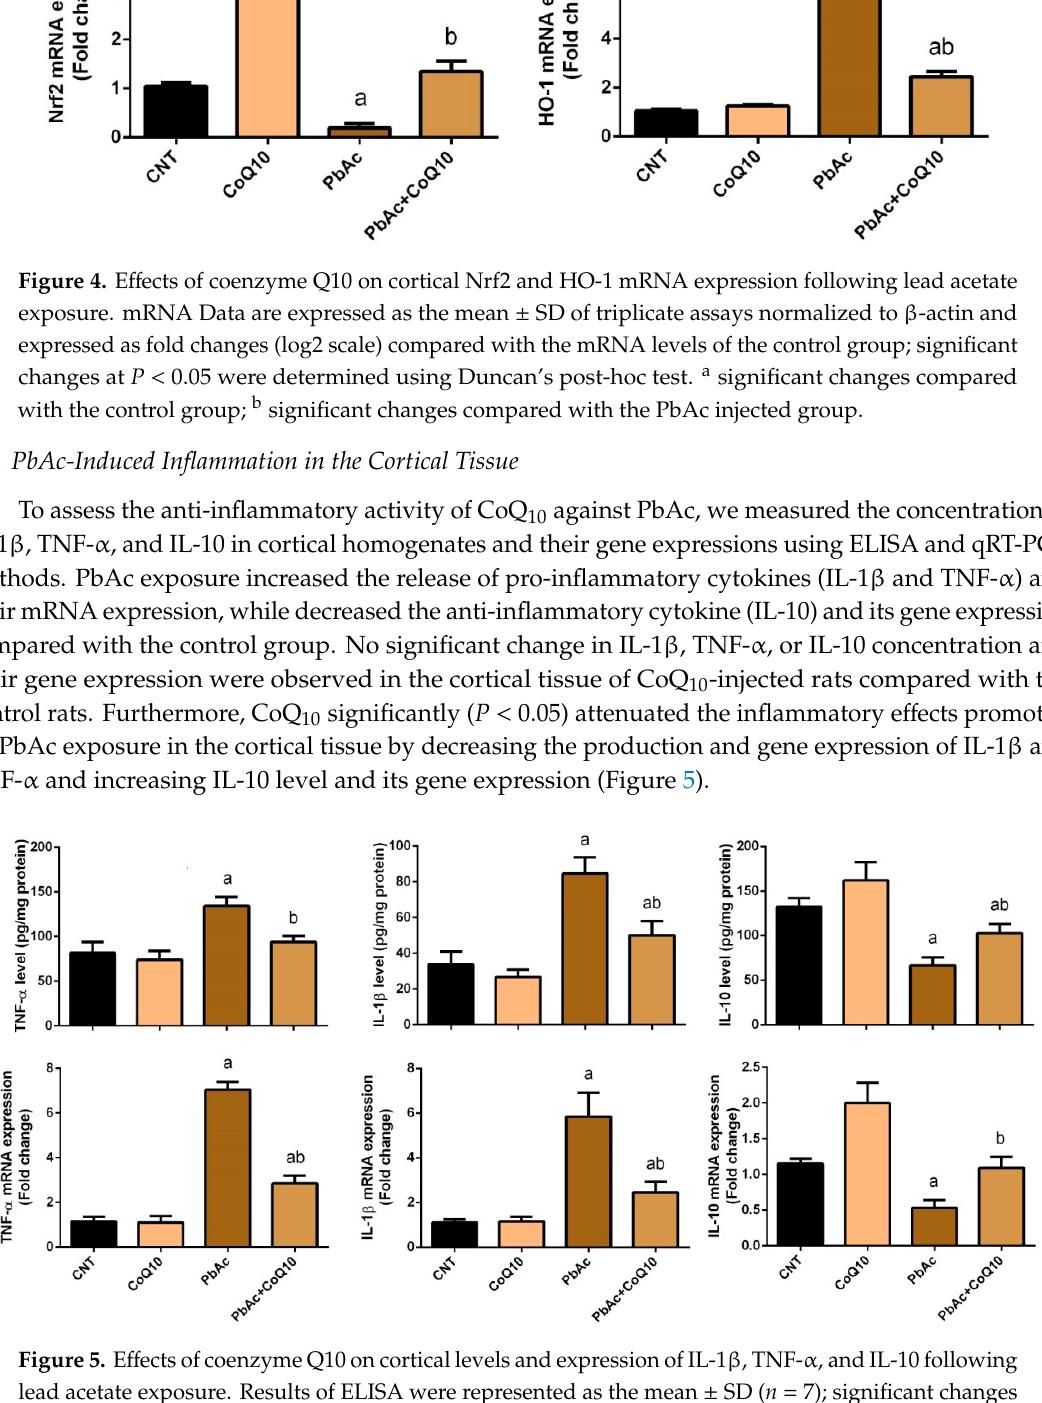
Figure 5. Effects of coenzyme Q10 on cortical levels and expression of IL-1 β , TNF- α , and IL-10 following lead acetate exposure. Results of ELISA were represented as the mean ± SD ( n =